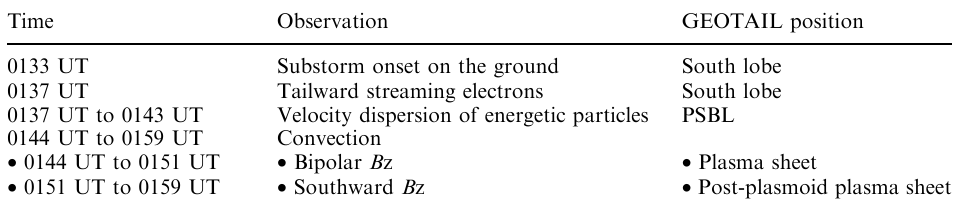
Table 2. The sequence of events as determined from the analysis of GEOTAIL data for the flux rope signature centred at 0147 UT on March 31,